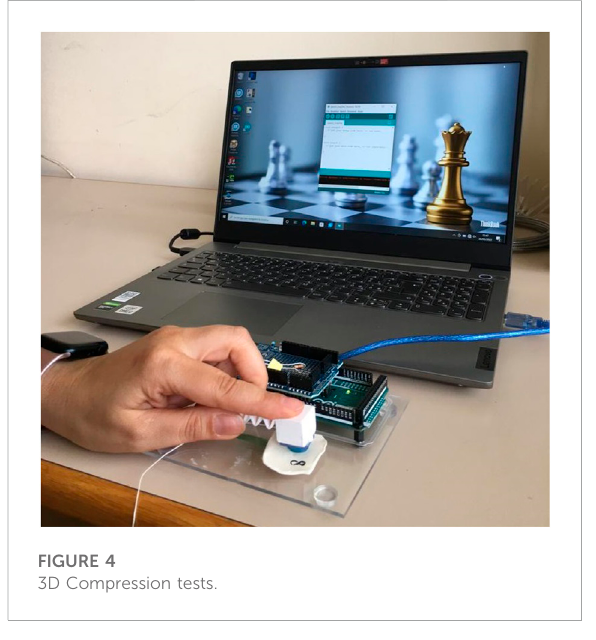
FIGURE 4 3D Compression tests.